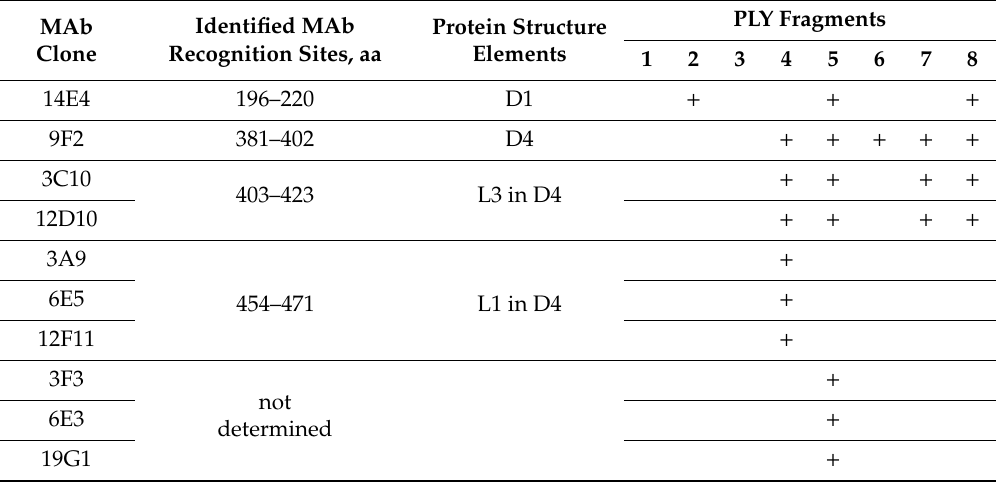
Table 6. The results of MAb epitope mapping using a series of overlapping PLY fragments.